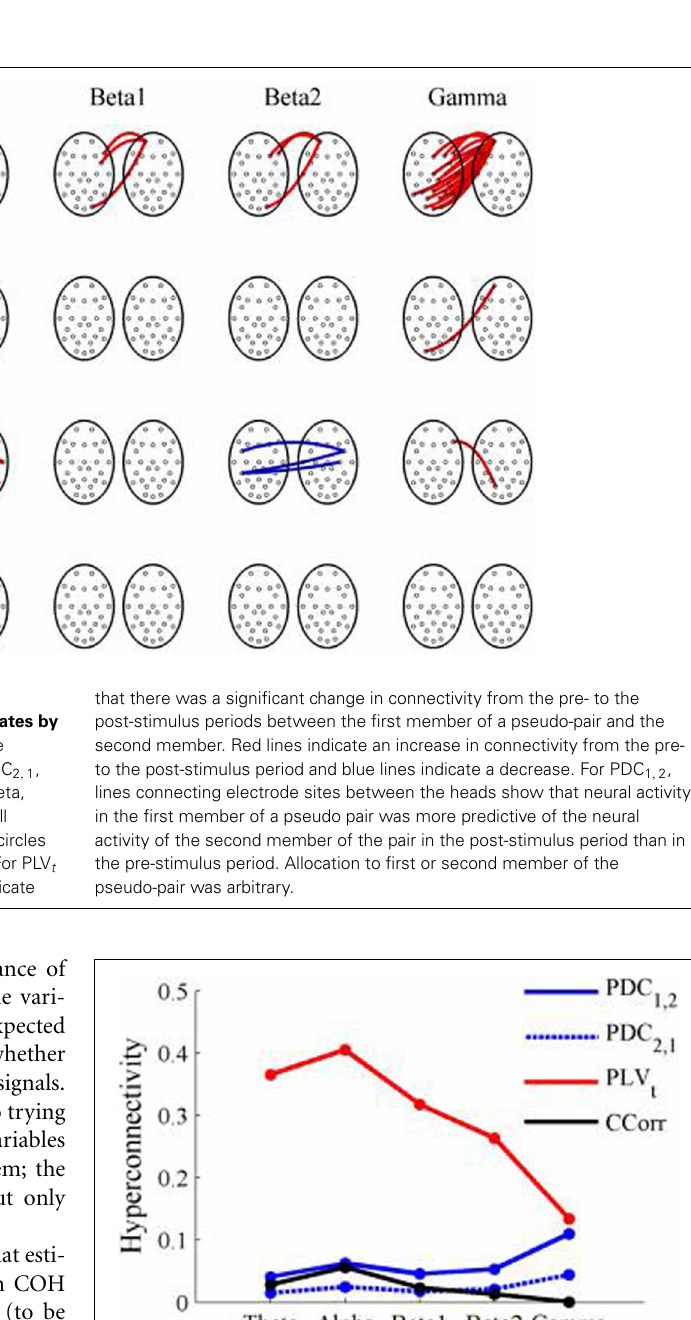
FIGURE 13 | Mean Hyperconnectivity values for time-averaged resting state EEG by connectivity measure and frequency band.